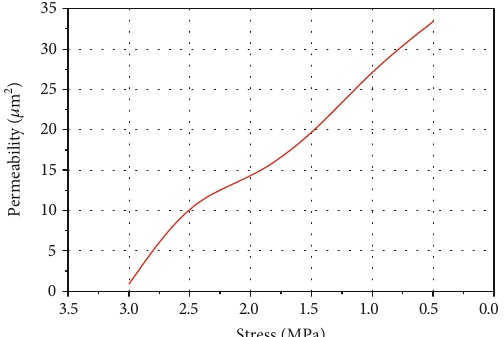
Figure 11: Con fi ning pressure-permeability change curve of coal specimen